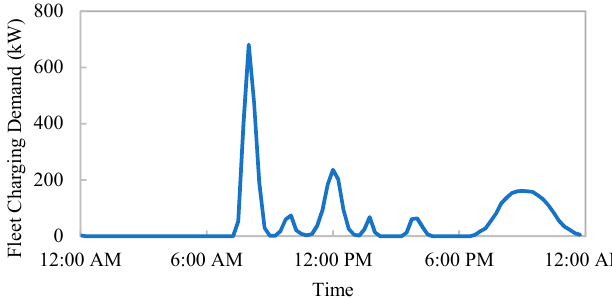
Figure 5 . Representative uncontrolled charging demand for the EV fleet in the Laurier case study.